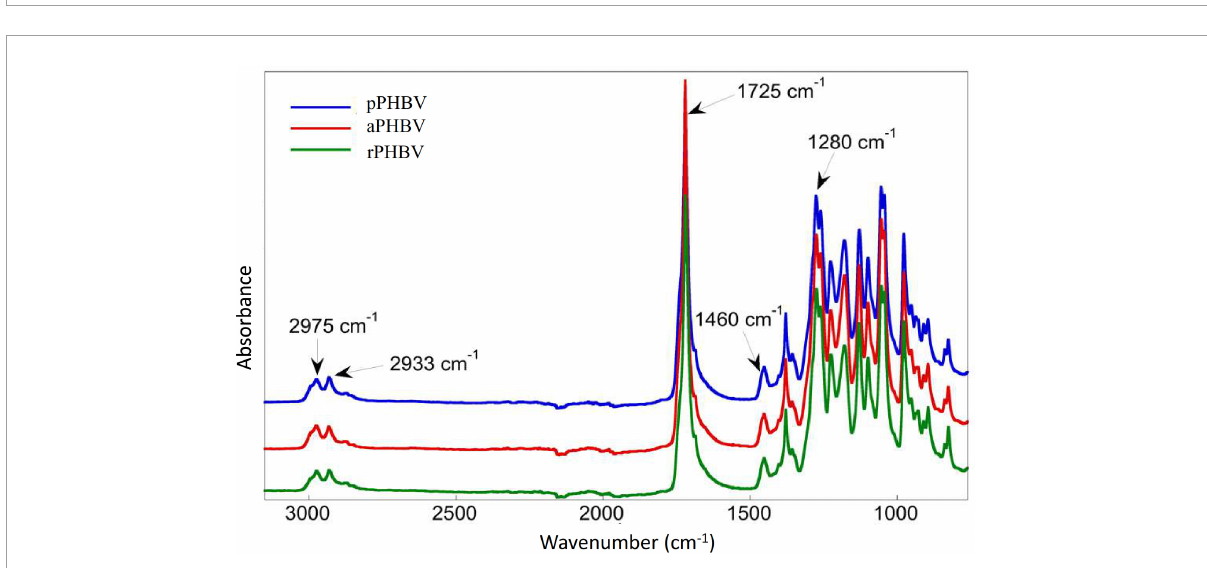
FIGURE4 FT-IR spectra of PHBV produced in the wasted bread/seawater substrate: pPHBV, obtained from the CHCl 3 :H 2 O separation and the precipitation with cold ethanol; rPHBV, obtained by the replacement of the CHCl 3 :H 2 O separation with repeated washing with water; aPHBV, obtained by the replacement of the CHCl 3 :H 2 O separation with repeated washing with water, but followed by solubilization in CHCl 3 and purification with cold ethanol.